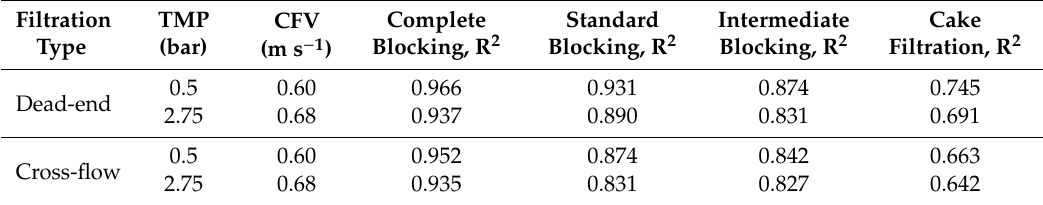
Table 6. R 2 values for both dead-end and crossflow filtration